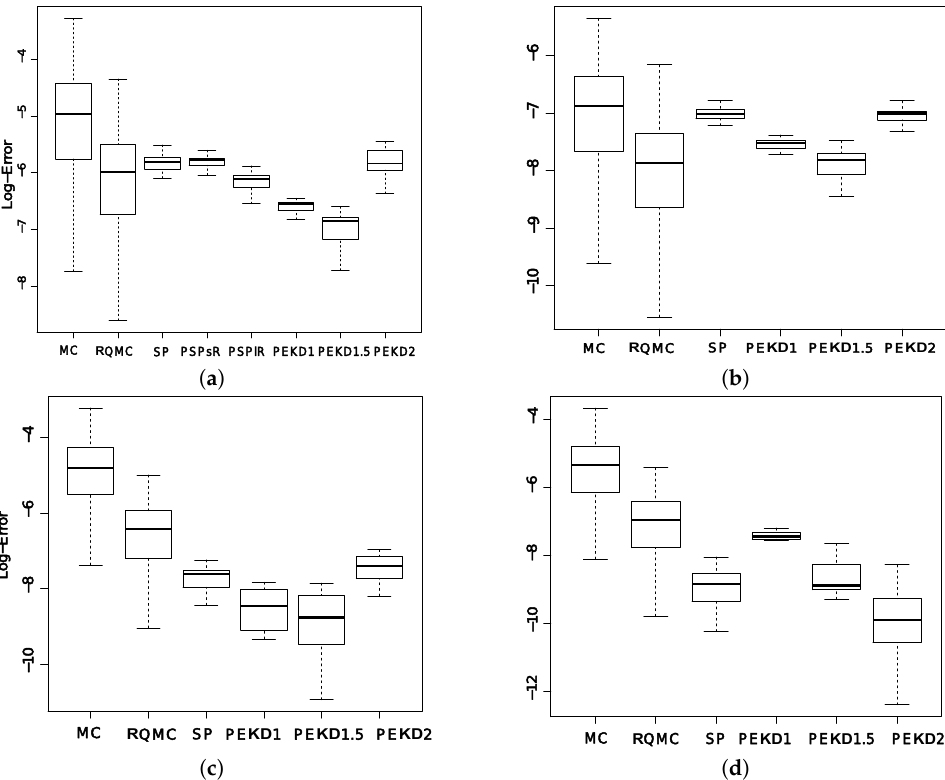
Figure 5. Box plots of Log-Error for GAPK and ADD under p dimensional i.i.d. N ( 0,1 ) and Exp ( 1 )